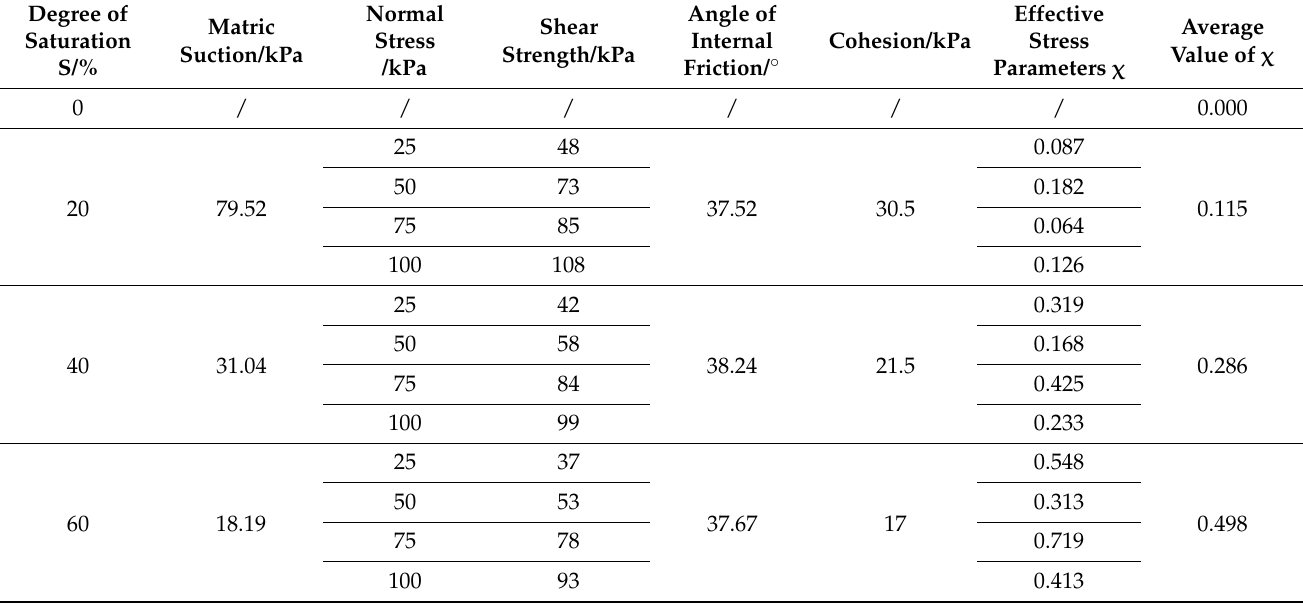
Table 5. Effective stress parameters χ deduced from